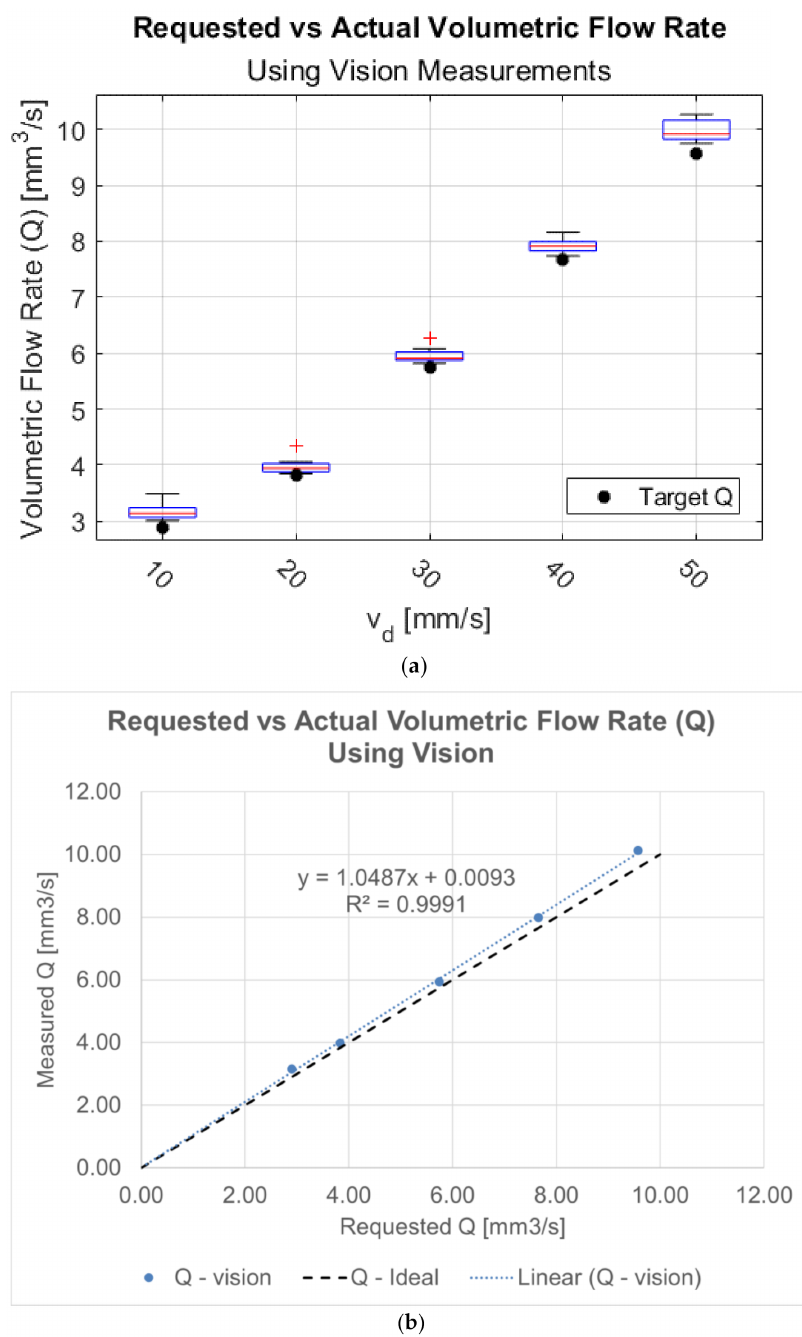
Figure 11. Output volumetric flowrate calculated using vision-based extrusion width measurements and part height measurements. ( a ) Box plot showing for Q out for different deposition velocities; ( b ) Q out calculated using vision (blue line) vs. requested from the slicer. The dotted black line shows an ideal case where measured Q out = requested Q out